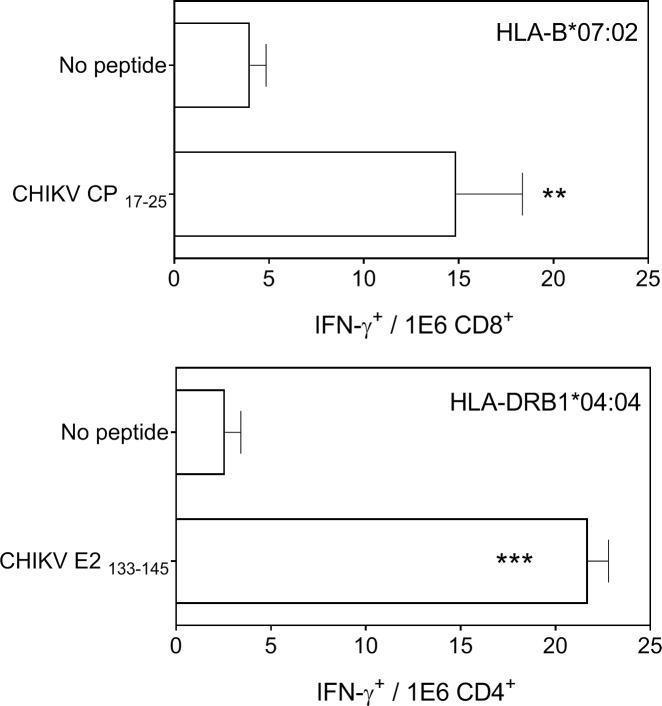
Immunogenicity of CHIKV-derived HLA-B*07:02, and DRB1*04:04-restricted peptides in HLA transgenic mice.HLA-B*07:02 (top panel), or -DRB1*04:04 (bottom panel) target cells that were pre-pulsed with the indicated CHIKV-synthetic peptides (CP17-25 and E2133-145) were analyzed by ELISPOT for CD8+ or CD4+ T cell activation with CHIKV-specific splenocytes obtained from HLA-B*07:02 (top panel), or -DRB1*04:04 (bottom panel) transgenic mice 7 days (acute response) post rVACV-CHIKV immunization (1x106 pfu). The results are calculated as mean of seven independent experiments ± SD. Significant P values with a non-parametric Mann–Whitney U test: **, p <0.01; and ***, p <0.001 versus negative controls (no peptide) are indicated.